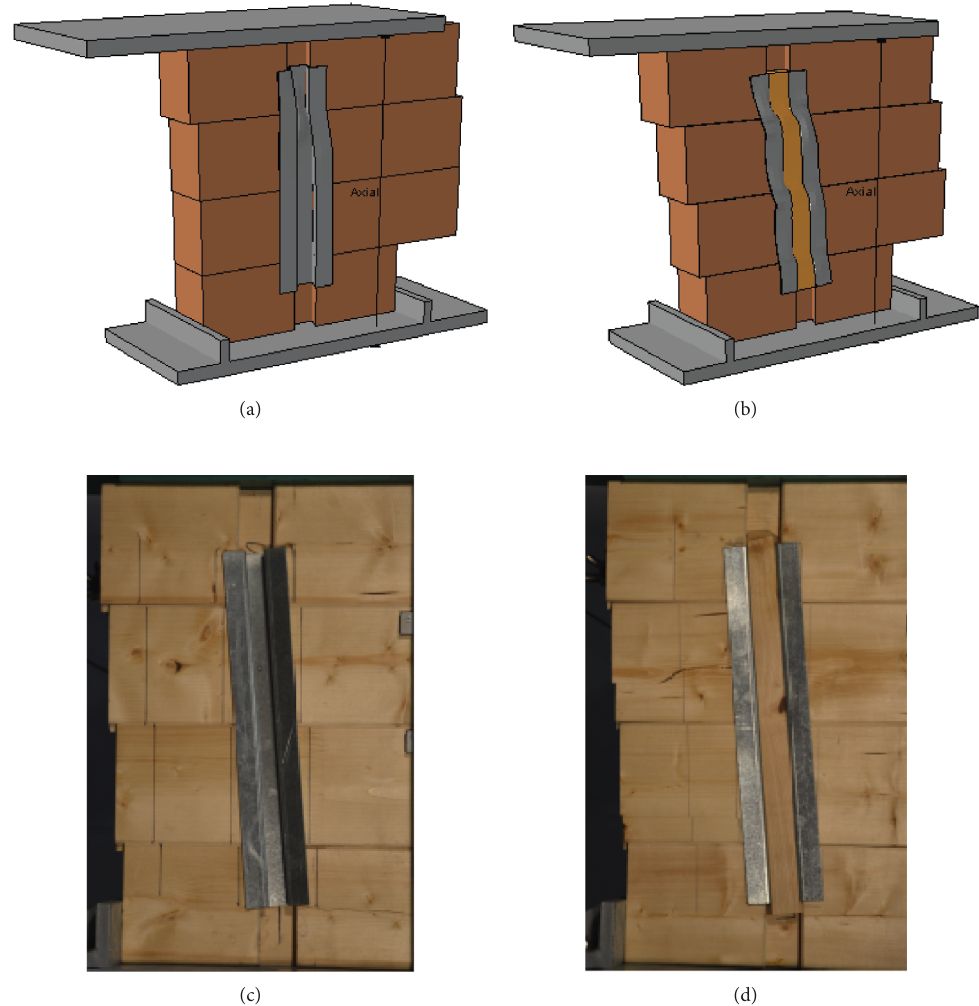
Figure 6: FE numerical response of (a) M01 and (b) M02 specimens, at an imposed lateral displacement of 40mm (ABAQUS). Overall deformed configuration, with (c) and (d) evidence of the ultimate deformed shape for the S01 and S02 specimens (detail pictures from [12–14]).